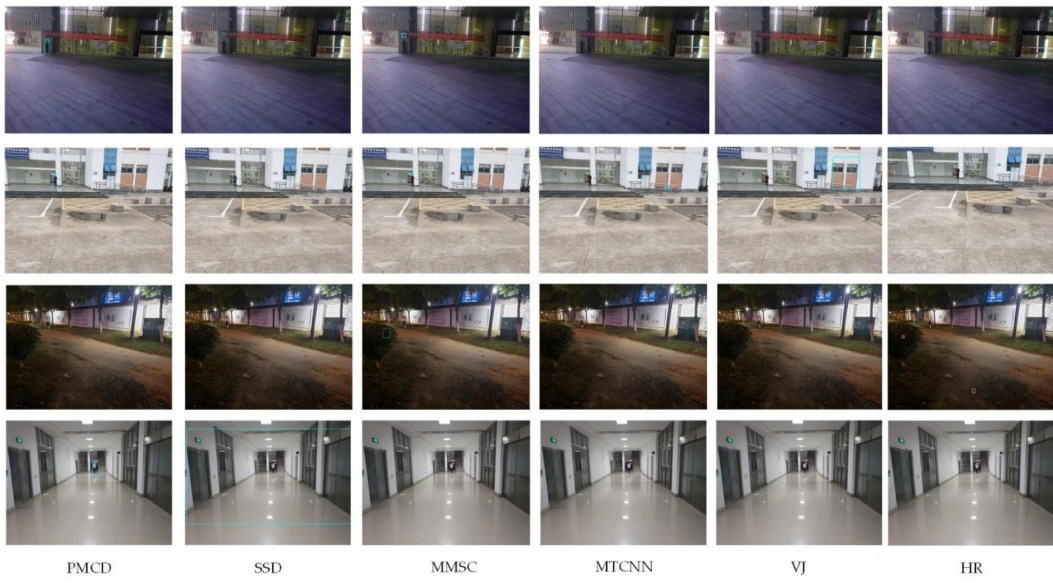
Figure 4. Face detection